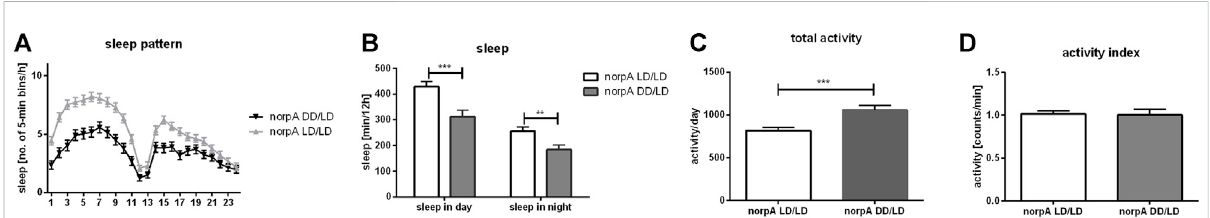
NorpA mutants show behavioral changes when developed without light. (A) Sleep pattern shows changes of sleep between experimental (DD/ LD) and control group (LD/LD). (B) Sleep level is decreased both, during the day and night. (C) Total activity is signi fi cantly increased in fl ies which